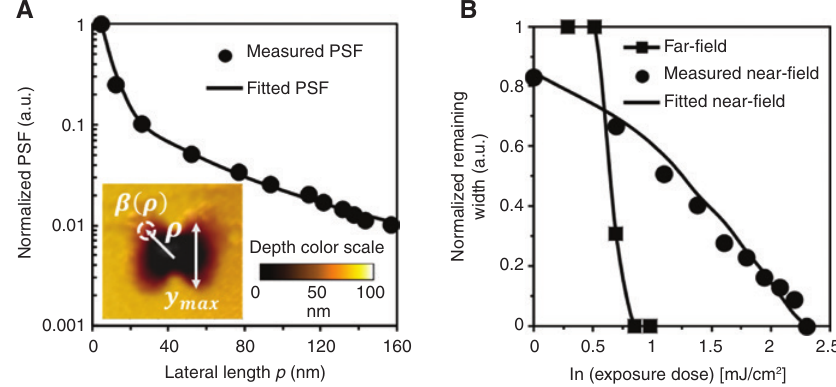
Figure 3: Normalized photoresist PSFs and photoresist contrast curves. (A) Measured curve of the normalized photoresist PSFs obtained by analyzing the features of the (solid circles) spot-mapping patterns and (solid line) fitted curve of the normalized photoresist PSFs. Inset: AFM image of the generated spot pattern. y y -direction, ρ is the lateral length, and β ( ρ ) is the corresponding decay constant with respect to ρ . (B) Photoresist contrast curve of (solid line with squares) far-field lithography, (solid circles) measured photoresist contrast curve of NFL, and (solid line) fitted photoresist contrast curve using the analytic formula of the photoresist contrast for